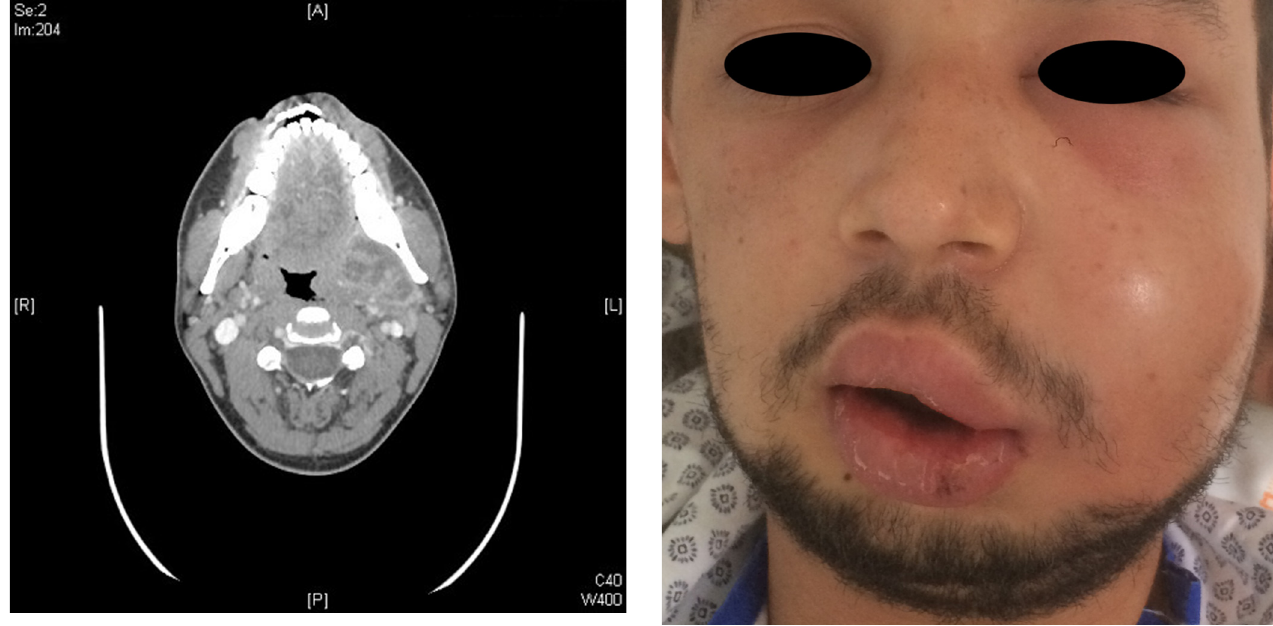
Fig. 1. Axial CT scan with contrast administration taken on the day of admission.